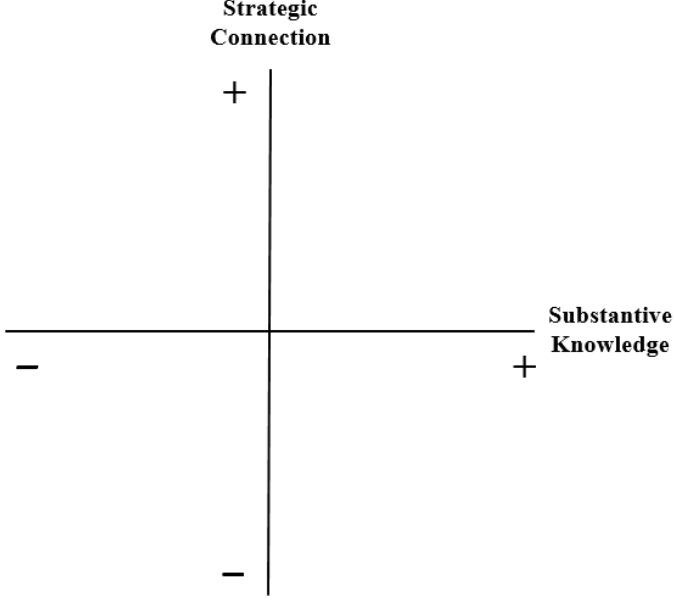
Figure 1. Two ‐ dimensional model of strategic competence. Figure 1. Two-dimensional model of strategic